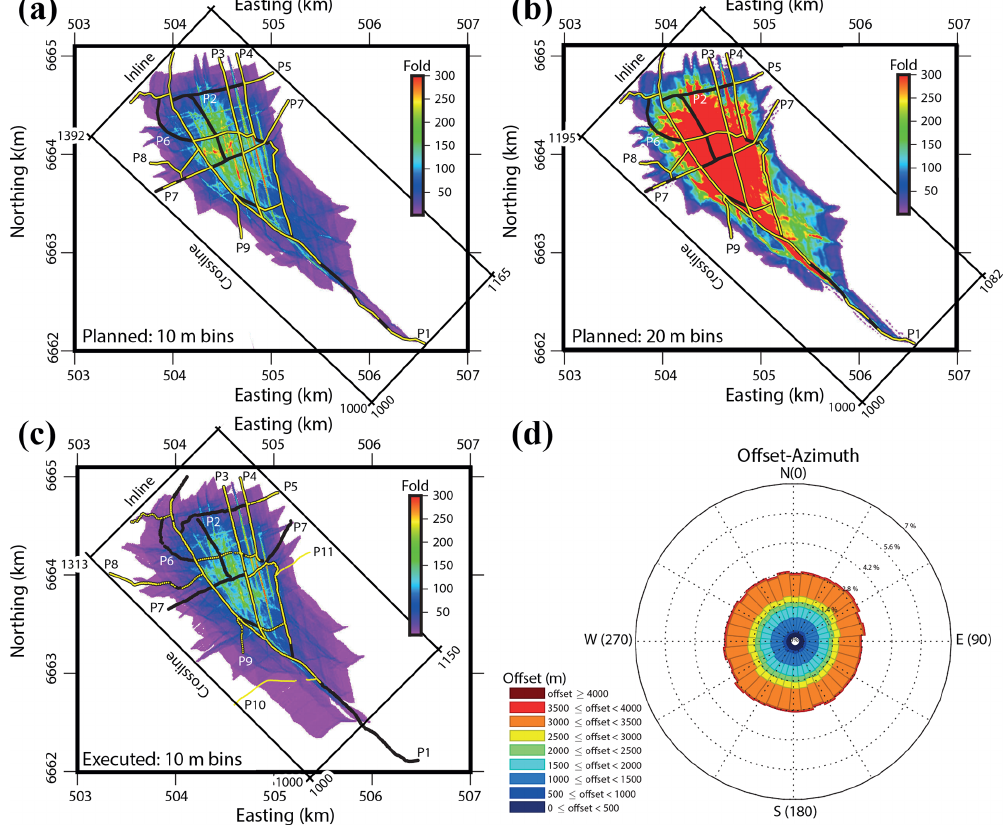
Figure 5. Planned versus executed 3D survey at Blötberget. Planned survey and fold coverage using (a) 10m and (b) 20m regular CDP bins. (c) Executed survey and fold coverage using 10m regular bins as used for the processing of the dataset. (d) Planned offset-azimuth coverage. The executed survey is shown in Fig. 1b. Yellow points are shot locations, and black points are receiver positions (see also Fig. 1a). While the planned survey had more uniform offset-azimuth coverage, due to permitting issues shots on the southern portions of P1, P7 and parts of P5 could not be covered. The planned survey also aimed for 1500 receivers, whereas at the end only 1266 became available. The executed survey ended to cover more areas west of the survey area, which was important in imaging westward extension of the deposits as discussed in the